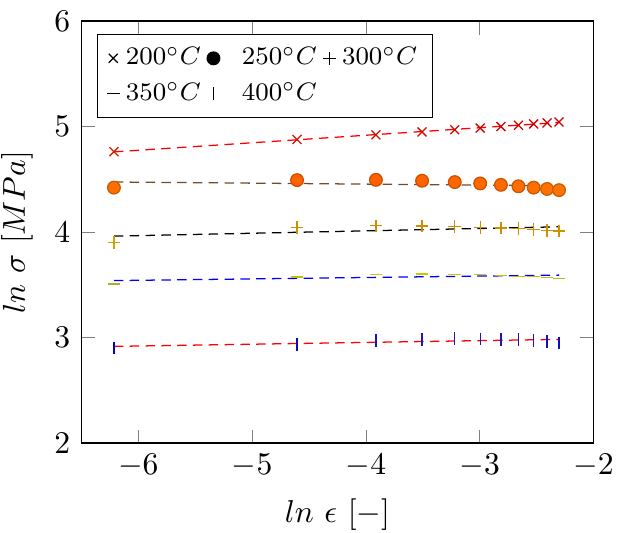
Figure 4. Relationship between ln σ and ln (cid:101) for the sample formed in the tool with a temperature of 350 ◦